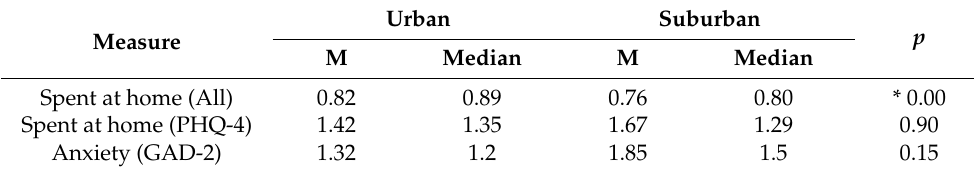
Table 6. Summary statement on the urban-suburban time spent at home, depression,